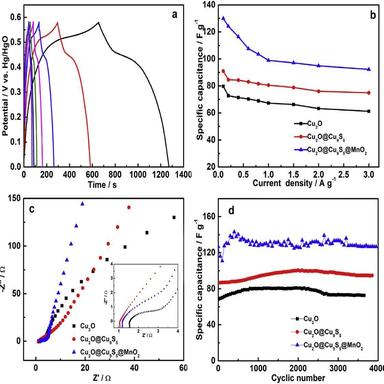
(a) Galvanic charge-discharge curves of the three electrodes at different discharge current densities; (b) specific capacitance with varying current density; (c) Electrochemical impedance spectroscopy of Cu2O, Cu2O@Cu9S5, and Cu2O@Cu9S5@MnO2; (d) cycling performances of the three electrodes during 4000 cycles at a current density of 0.1 A g1 .